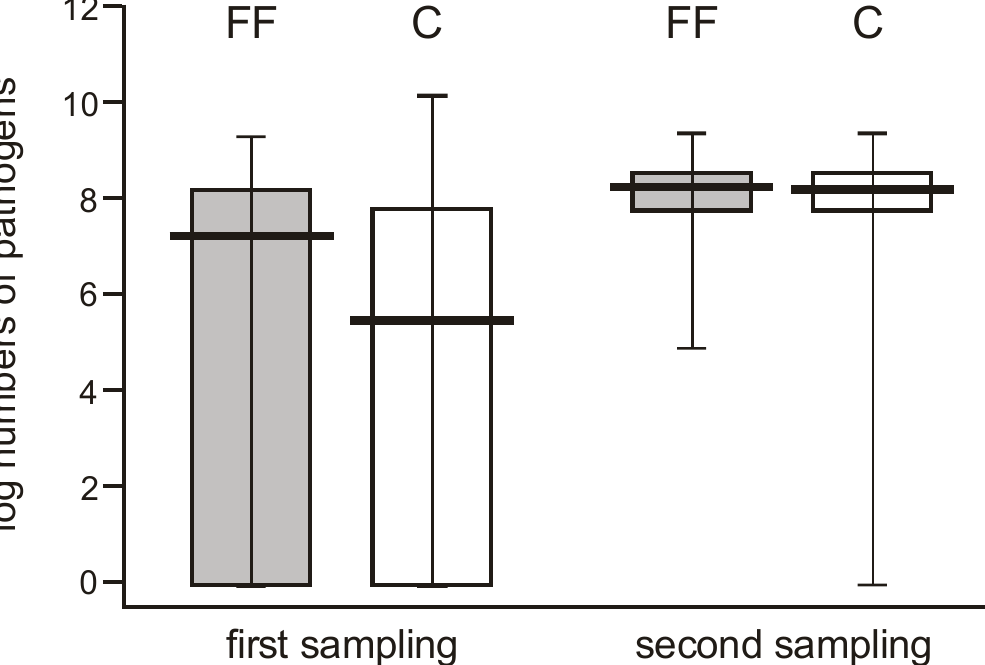
Figure 6. Changes in populations of the potentially pathogenic bacteria ( Clostridium , Staphylococcus , Enterococcus , Klebsiella , and Escherichia coli taken together) found in 2 consecutive feces samplings obtained from neonates of the probiotic-supplemented and control group (Mann–Whitney test Z = 5.50712; p < 0.000001 and Z = -448466; p < 0.000007).